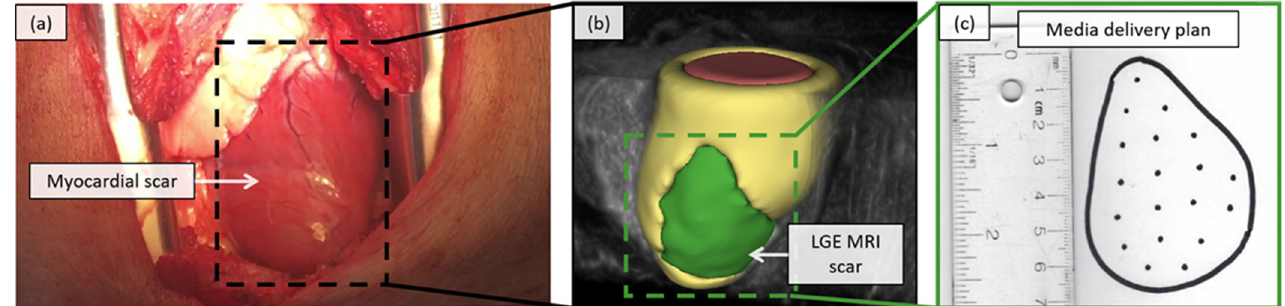
Figure 1. ( a ) Open chest surgical scene from a left lateral thoracotomy procedure, for delivery of a candidate therapy, in a porcine model of myocardial infarction, with ( b ) data from late gadolinium- enhanced magnetic resonance imaging (LGE MRI) to characterize myocardial scar tissue (green region), and ( c ) an example markup of a targeted media injection pattern, for the delivery of a candidate therapy, across the identified scar (target injection sites spaced 1 cm apart).